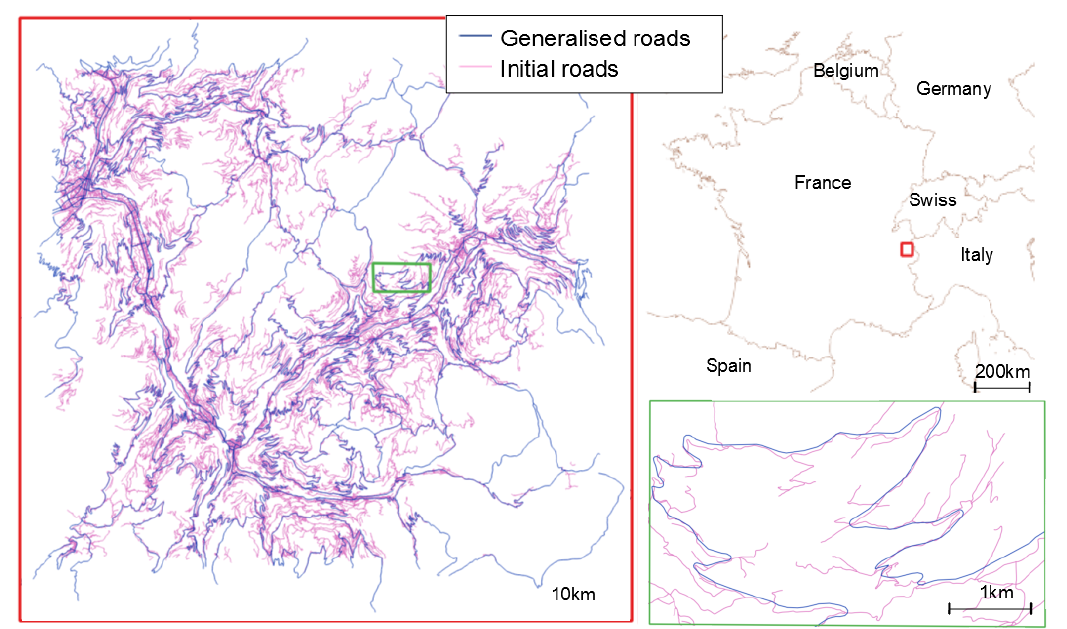
Figure 1. The complete dataset is displayed on the left, with its location in the top right overview map, and a detailed section at large scale at the bottom right to better show the differences in detail between